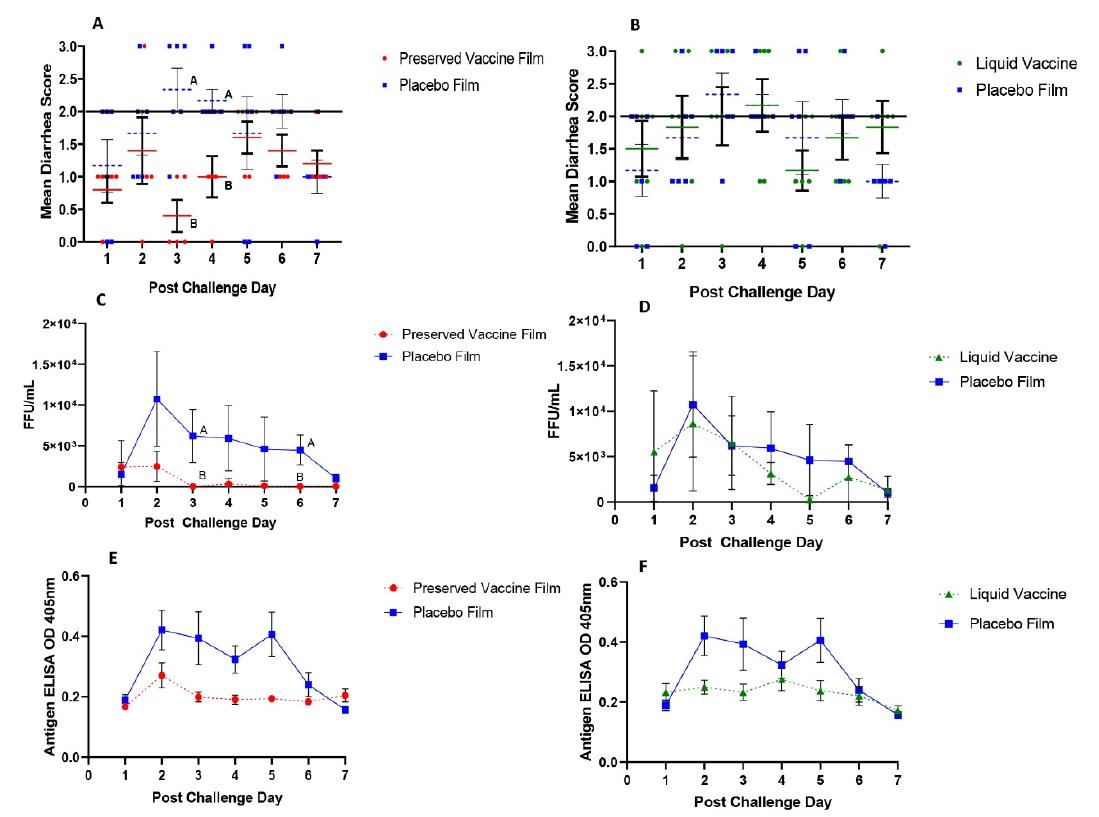
Figure 1. Diarrhea score and virus shedding postchallenge in Gn pigs vaccinated with preserved film vaccine ( A , C , E ) or